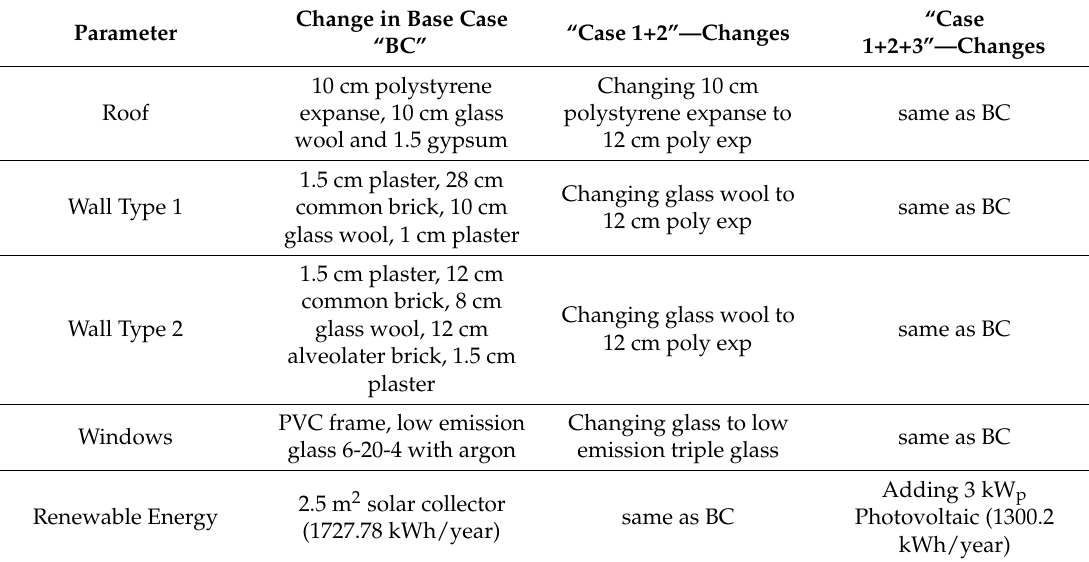
Table 5. The comparison study base case and the best cases parameter changes [28].